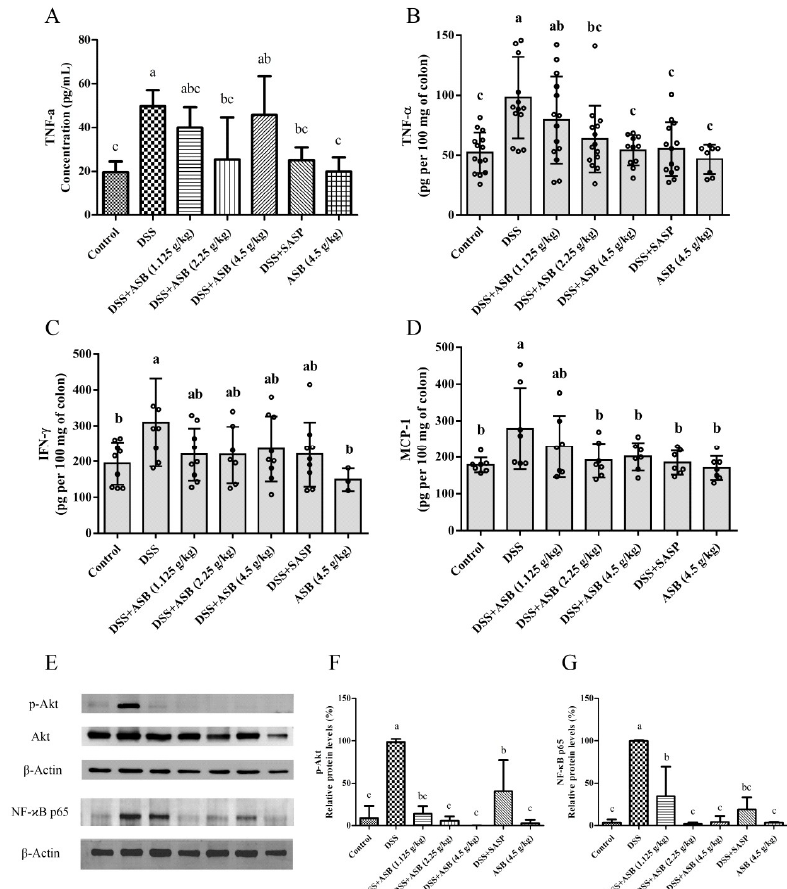
Figure5. ( A )E ff ectsofASBontheproductionofcytokinesTNF- α intheserumofmicewithDSS-induced colitis ( n = 3). E ff ects of ASB on the production of cytokines ( B ) TNF- α (C: control, n = 14; D: DSS model, n = 14; L: DSS + ASB low dosage, n = 14; M: DSS + ASB medium dosage, n = 14; H: DSS + ASB high dosage, n = 11; P: SASP, n = 13; T: ASB high dosage reference, n = 8), ( C ) IFN- γ (C: control, n = 9; D: DSS model, n = 8; L: DSS + ASB low dosage, n = 9; M: DSS + ASB medium dosage, n = 7; H: DSS + ASB high dosage, n = 9; P: SASP, n = 9; T: ASB high dosage reference, n = 3), and ( D ) MCP-1 ( n = 7) in the culture supernatants of colonic tissue of mice with DSS-induced colitis. ASB ameliorates DSS-induced colitis via the TLR4-linked NF- κ B signaling pathway. ( E ) Protein levels of p-Akt and NF- κ B in the colon were assessed by Western blotting. ( F , G ) Relative protein levels of p-Akt / β -Actin and NF- κ B / β -Actin ( n = 3). Results were expressed as mean ± SD. Parameters marked by the same letter are not significantly di ff erent. Significance is represented as p <